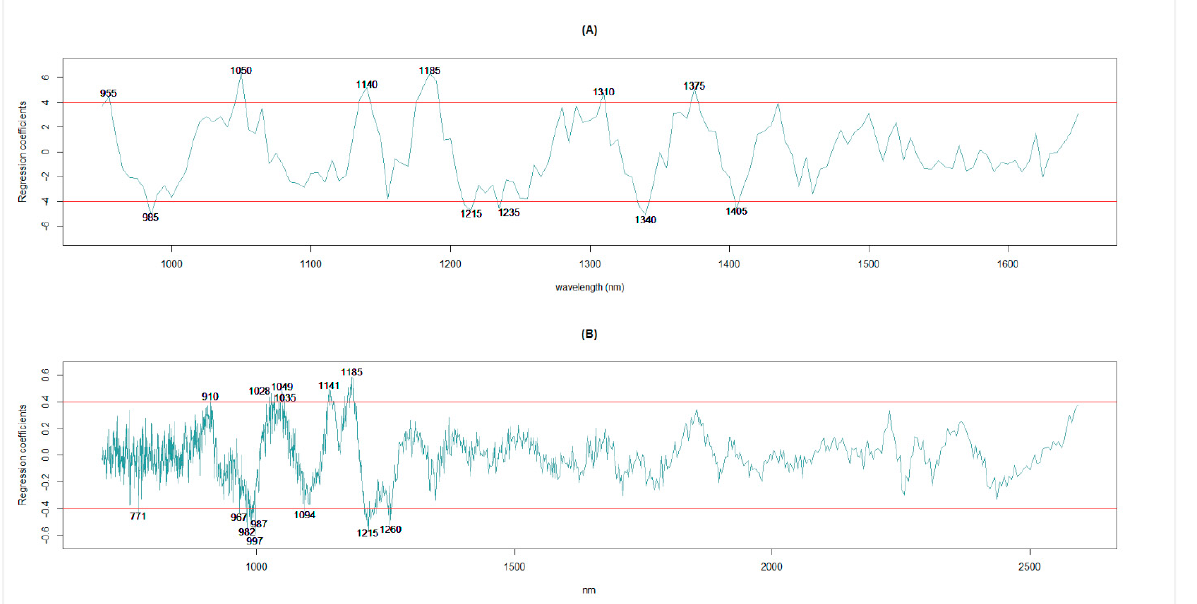
Figure 6. Plots of regression coefficient for the PLSR models with optimum number of latent variables (10 for DA7250 and 13 for FT9700) against spectral wavelengths (950 nm to 1650 nm for DA7250 and 699.5 nm to 2593.4 nm for FT9700). The models were: ( A ) PLSR using DA7250 spectral data and ( B ) PLSR using FT9700 spectral data. The red horizontal line indicates threshold to declare high regression.